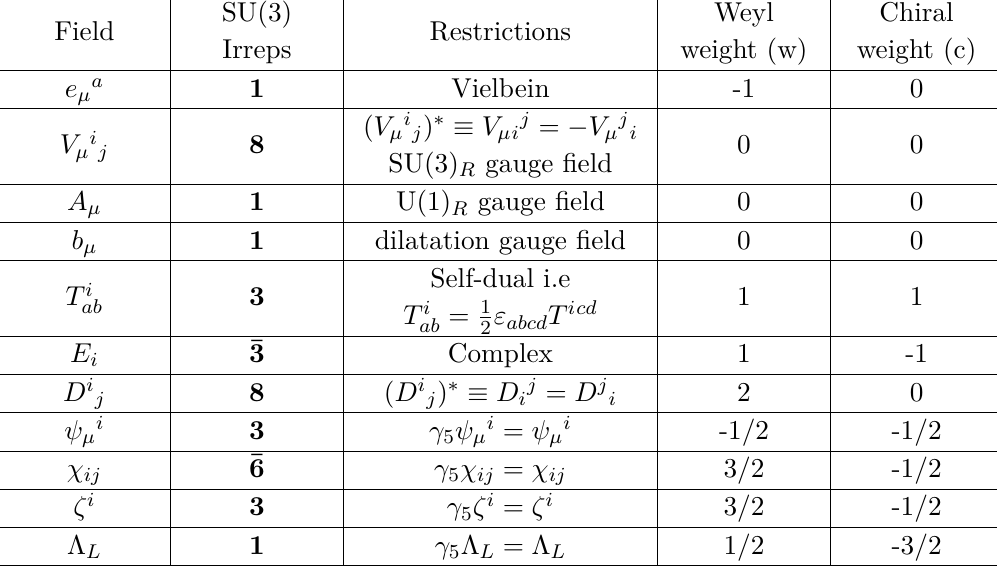
Table 1 . Field content of the N = 3 Weyl